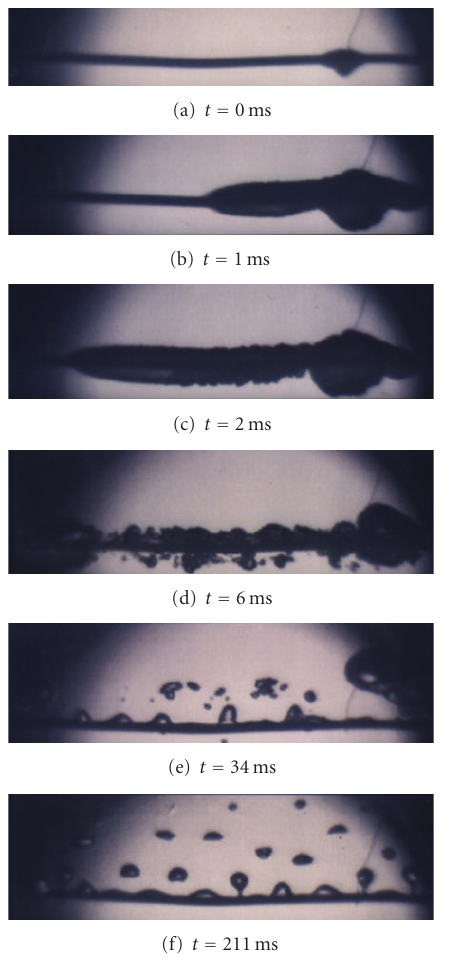
Figure 15: Vapor film behavior during direct transition to film boiling for a period of 10s at atmospheric pressure in saturated FC- 72 with the RS